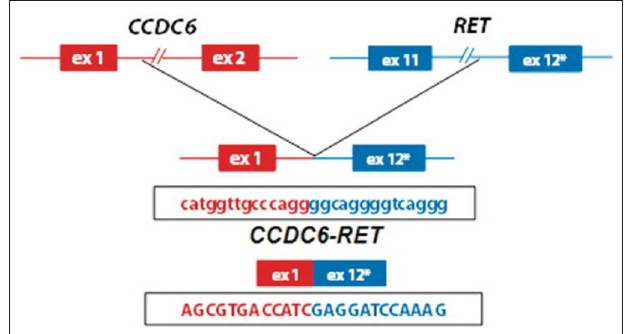
FIGURE 1 | Schematic representation of the CCDC6-RET fusion gene identified in patients with papilary thyroid cancer (8) (used with permission, copyright Nucleic Acids Research, Oxford University